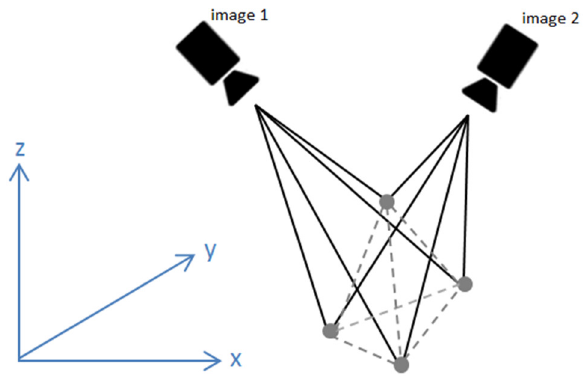
Figure 12. Principles of photogrammetry.